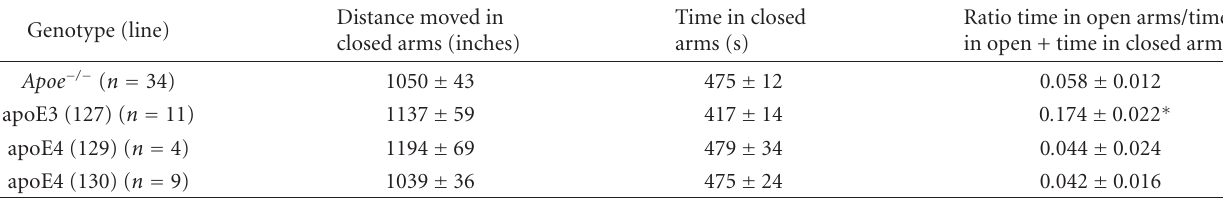
Table 2: Elevated plus-maze performance in 6-month-old GFAP-apoE male